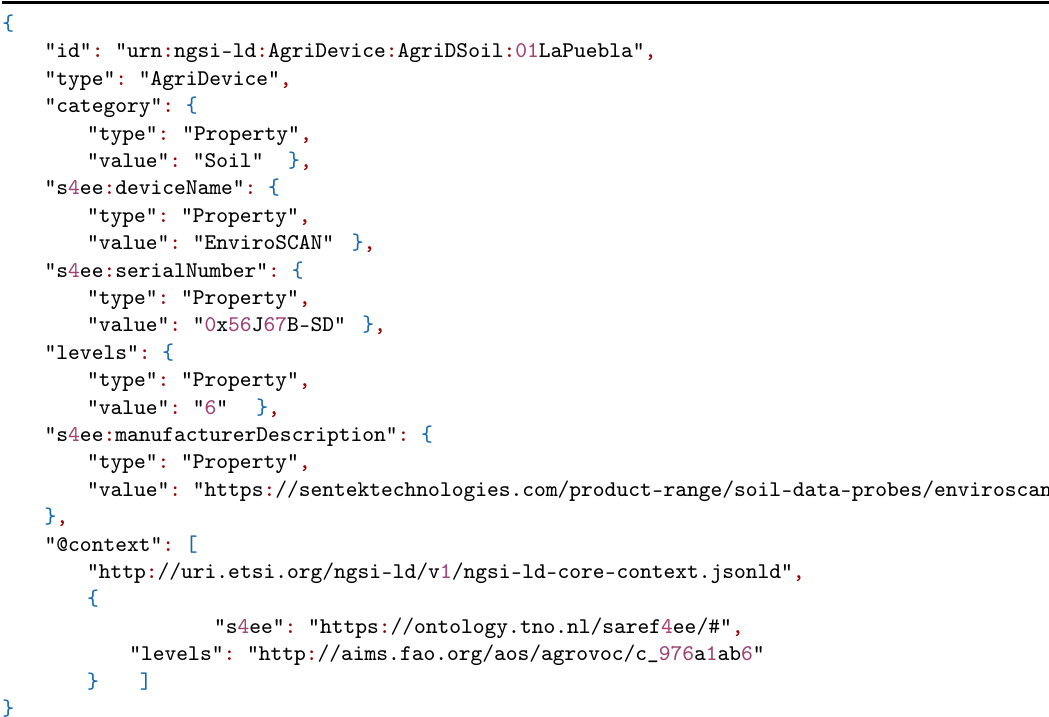
Listing 1. Next generation service interfaces with linked data (NGSI-LD) example representing an